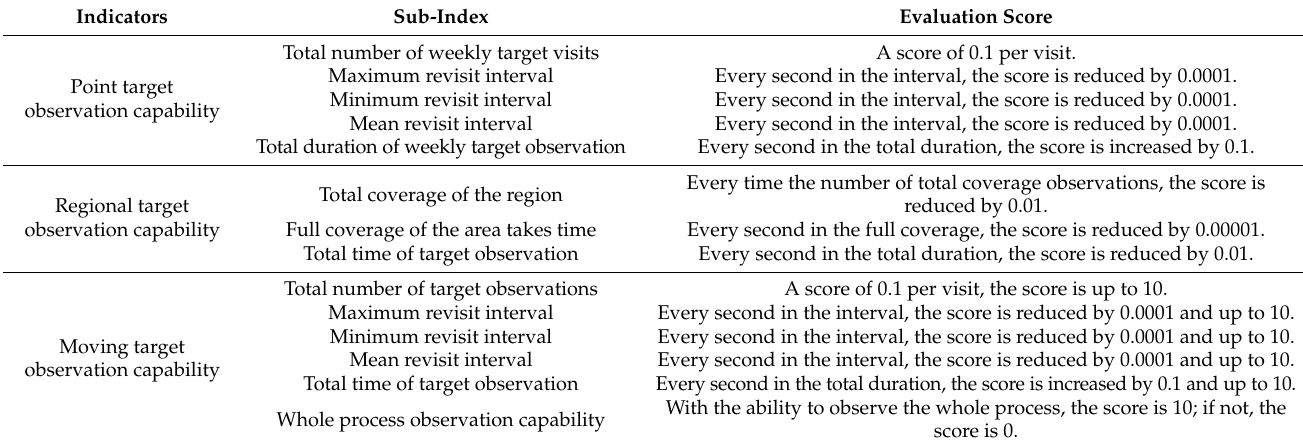
Table 3. Quantitative scoring methods for each